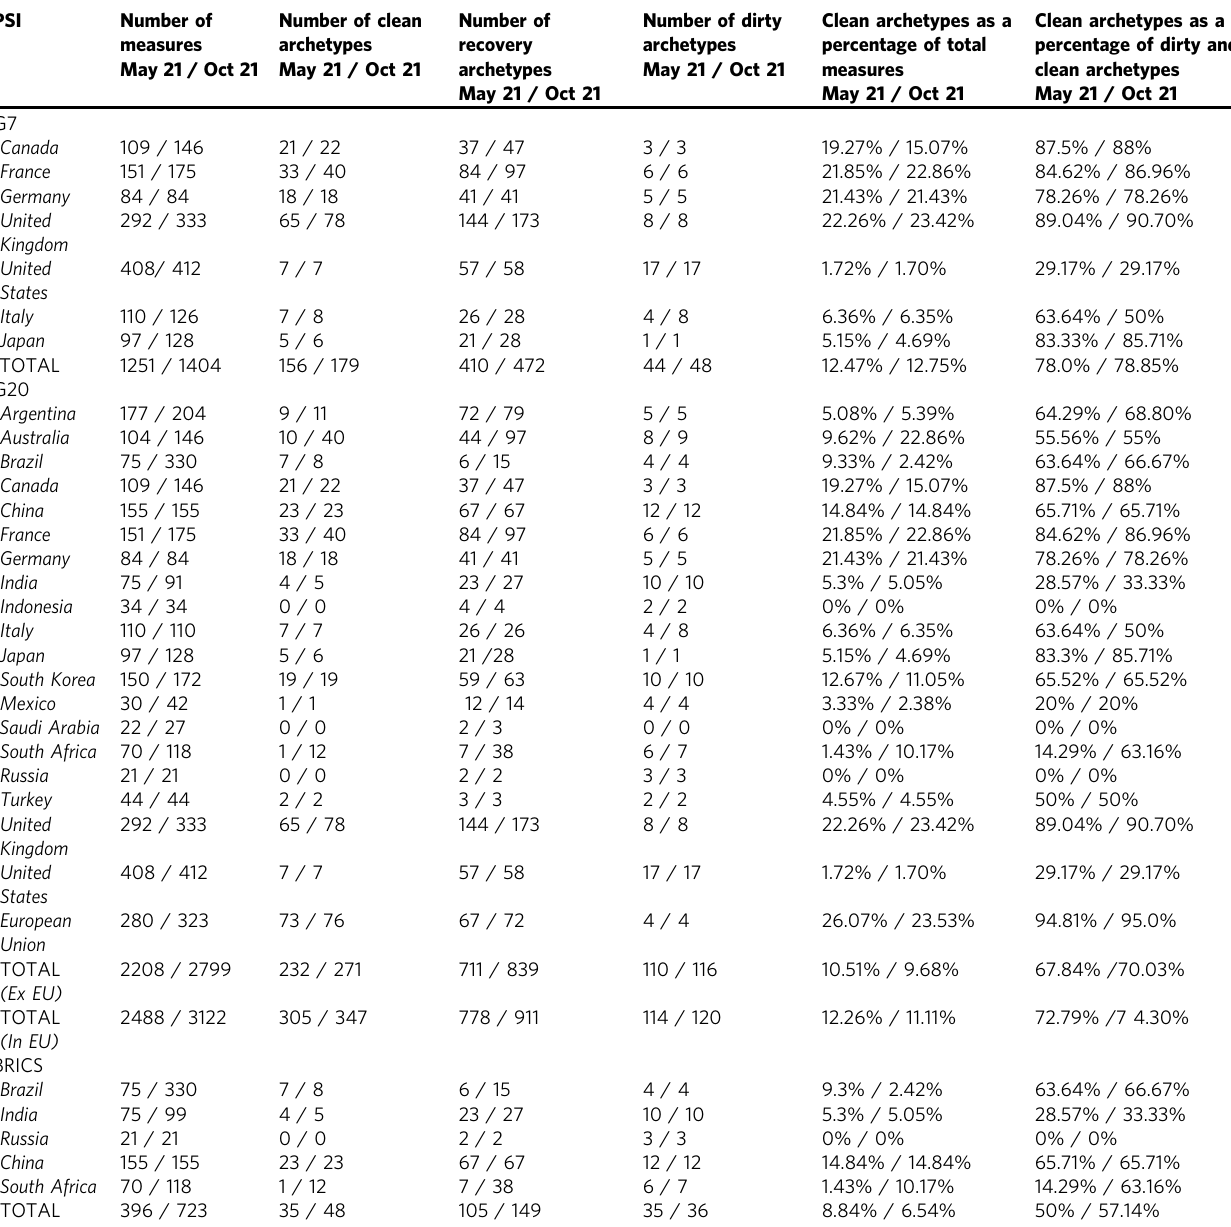
Table 1 Breakdown of plurilateral summit institutions ’ green recoveries as at May 24 2021/ Oct 11